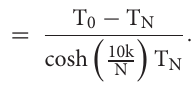
( b f WT ) for postulated projections P p . The phantom used for simulation of measured projections PM is shown in Figure 4